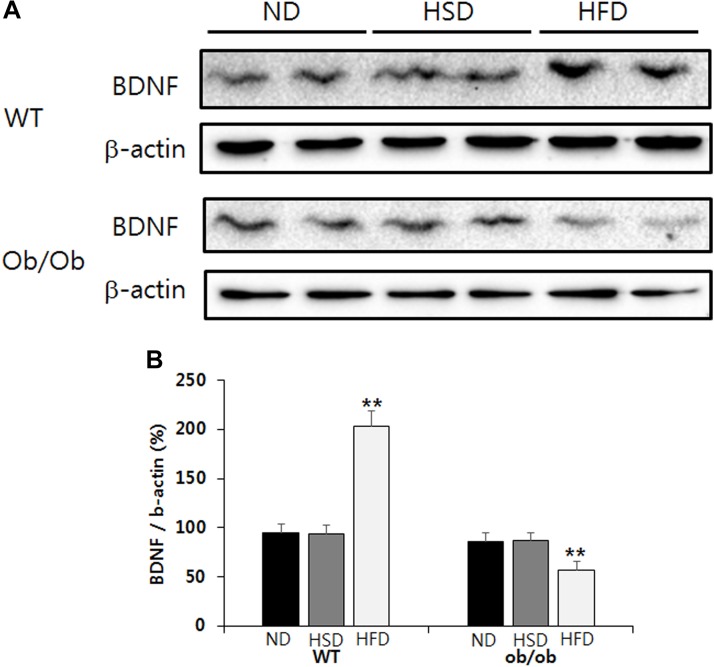
Western blot. The relative BDNF content in the brain cortex was analyzed by western blot (A). The relative density of protein bands was calculated using the Quantity One 1-D Analysis Software and normalized with β-actin (B). Data were expressed as mean ± SEM and statistically evaluated using one-way ANOVA followed by Bonferroni’s post hoc test. ∗∗P < 0.01 compared to ND and HSD (n = 7).